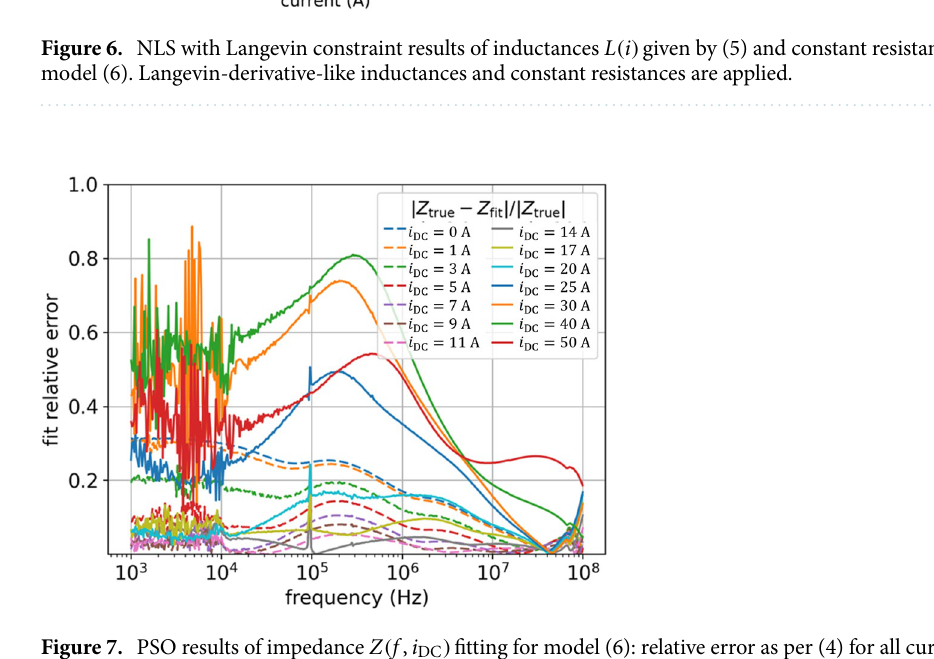
Figure 7. PSO results of impedance Z ( f , i DC ) fitting for model (6): relative error as per (4) for all currents. Unacceptable fitting